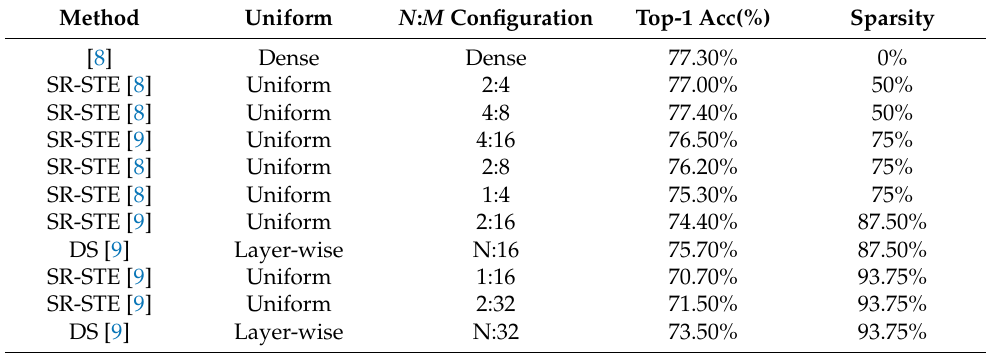
Table 1. the accuracy of N : M pruned networks under different configurations. Data are obtained from